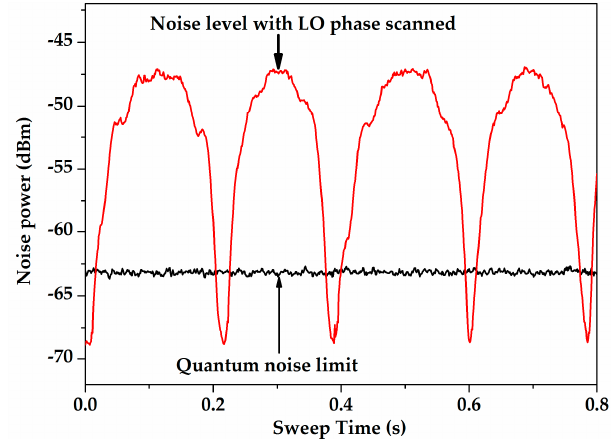
Figure 4. Quantum correlation noise of the phase quadrature sum. The measurement was recorded at an analysis frequency of 1 MHz, with a RBW (Resolution Band Width) of 200 kHz and a VBW (Video Band Width) of 100 Hz. The observed squeezing and anti-squeezing levels were − 6 dB and 16.4 dB, respectively.